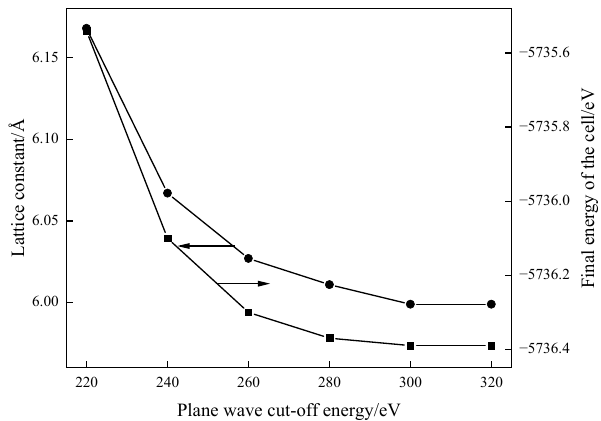
Figure 2. Lattice constant and final energy of the cell of galena as a function of plane wave cut-off energy.